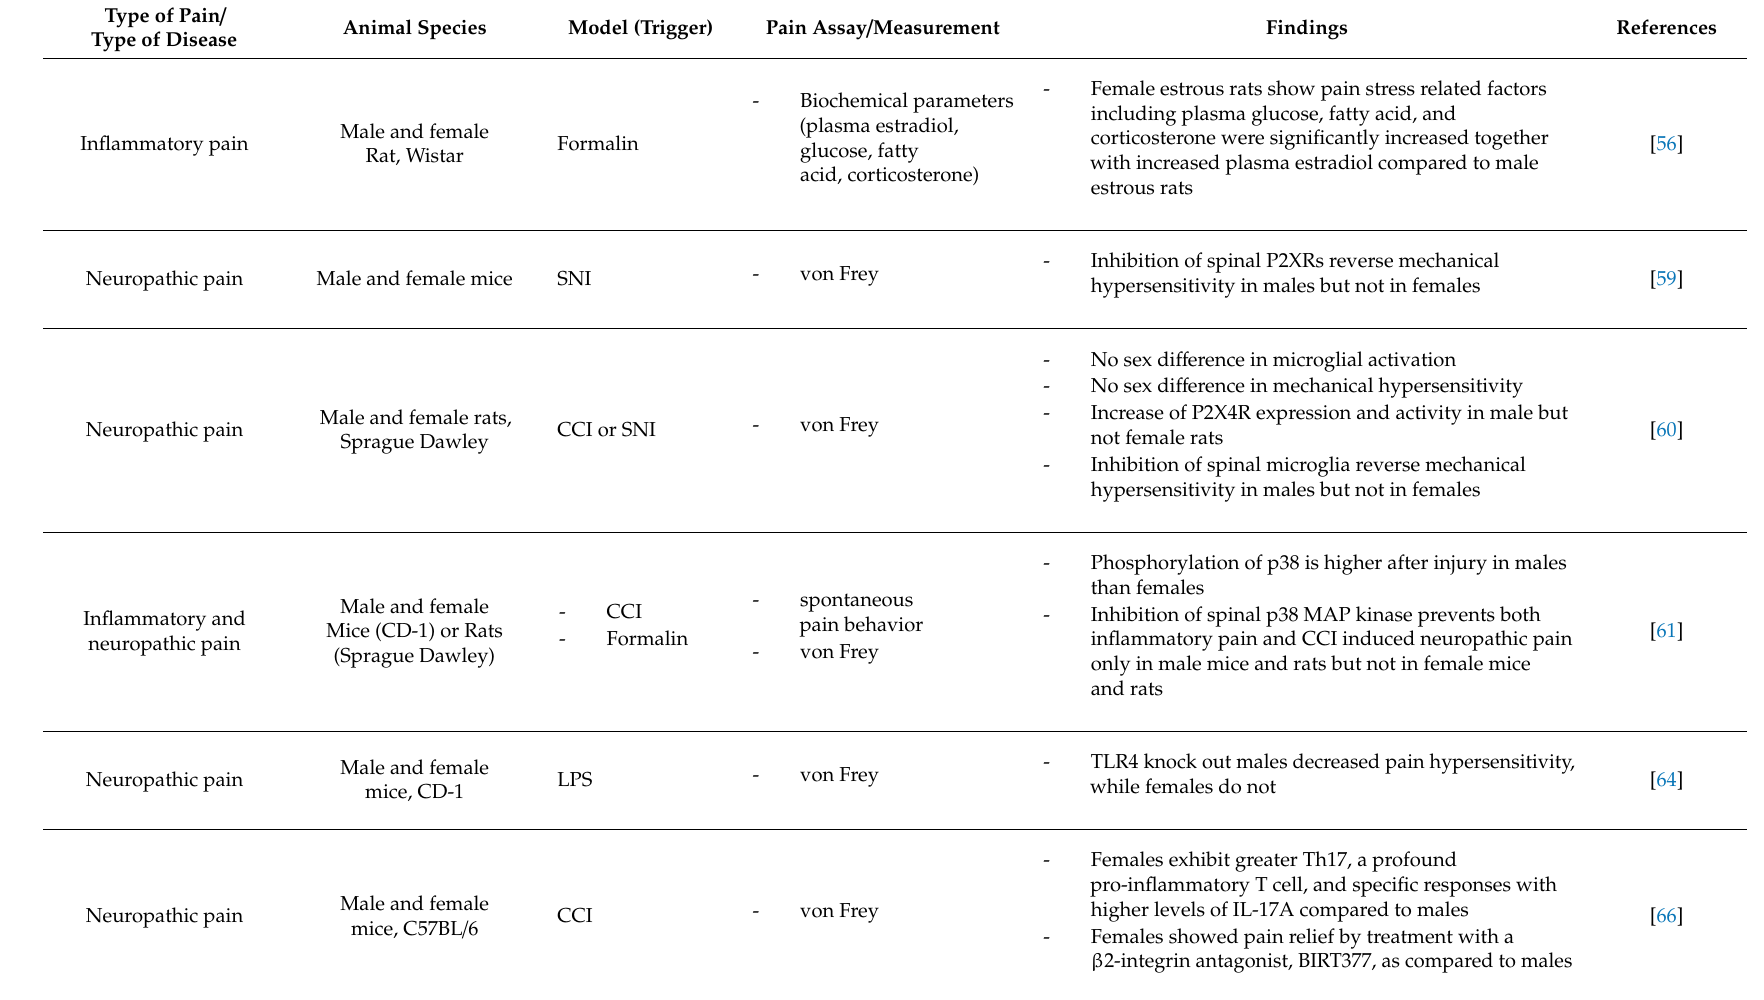
Table 2. Sex di ff erence in animal